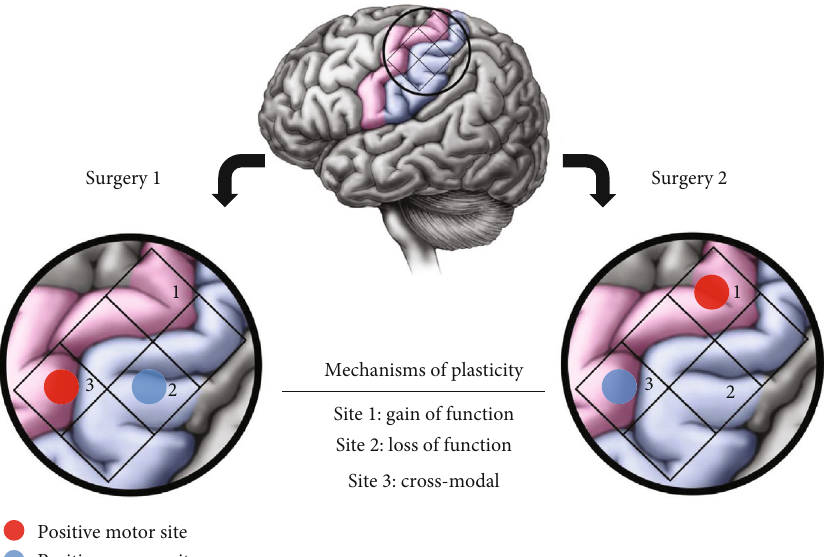
Figure 1: Mechanisms of plasticity. Plasticity occurred in three presumed mechanisms which are illustrated in this fi gure. Gain of function sites were negative to stimulation at the fi rst surgery and positive to stimulation at the second surgery (Site 1); loss of function sites were the inverse (Site 2). Cross-modal sites were positive to stimulation at both surgeries, but function changed from motor to sensory function or vice versa (Site